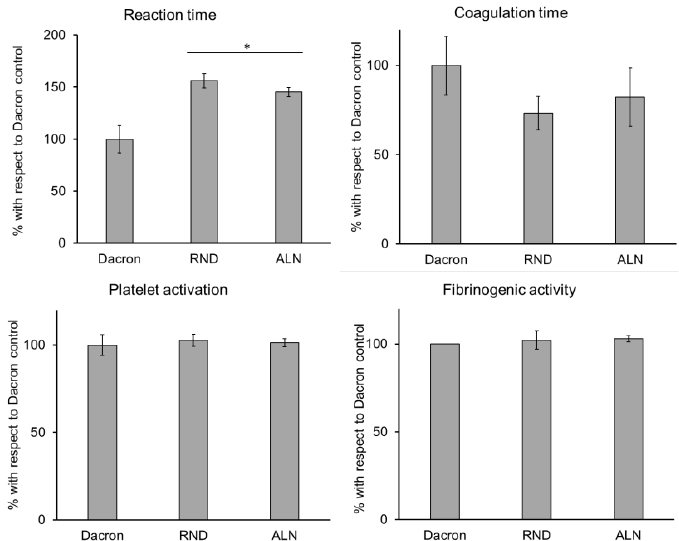
Figure 5. Hemocompatibility test on coagulation parameters evaluated on synthetic vascular substitutes (Dacron), RND, and ALN scaffolds. Data are expressed as mean values ± SD. (n = 3 from different healthy donors, * p ≤ 0.05).